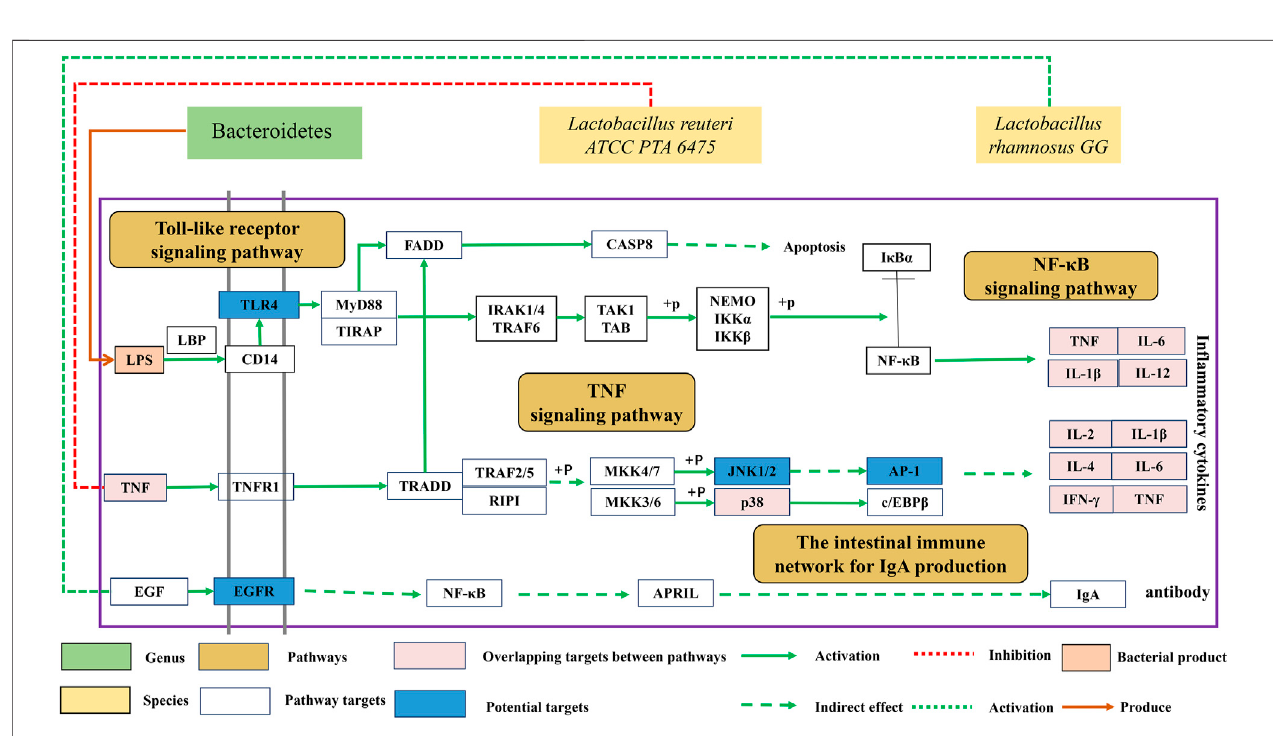
FIGURE 5 | Clustering heatmap based on Spearman correlation. Line color represents the direction of correlation: red (positive), green (negative), the deeper the color, and the stronger the correlation. * p < 0.05, and ** p < 0.01.